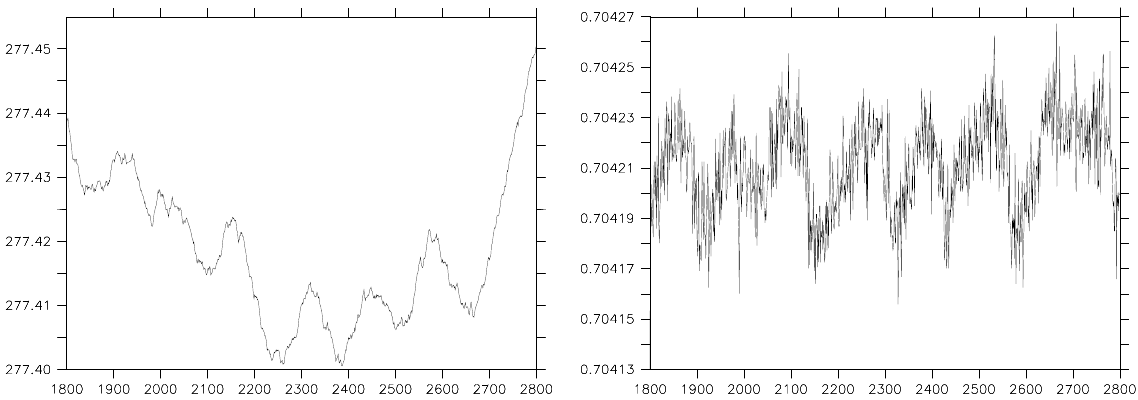
Fig. 2. The global annual mean ocean temperature in K (left) and salinity in PSU (right) in the SPEEDO control run. An offset of 34 PSU has been subtracted from the salinity data for this plot. Table 1. The time mean value, the standard deviation and the drift of the TOA and surface energy budgets, the global mean two meter temperature, the global mean ocean temperature and salinity and the total sea ice volume. The drift is defined as the mean over the last 100years minus the mean over the first 100years. Quantity Mean value Standard